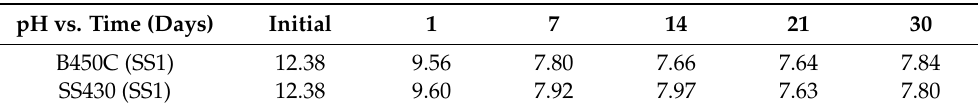
Table 5. Change in time of pH of the SS1 cement extract solution during the immersion of SS430 and carbon steel B450C up to 30 days.